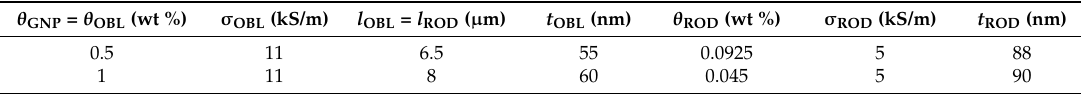
Table 1. Estimated fitting parameters of the Multiscale Maxwell Garnet (MMG) model applied to the measured complex effective permittivity of the epoxy-based composites produced in this study, as a function of the weight concentration of GNPs θ GNP